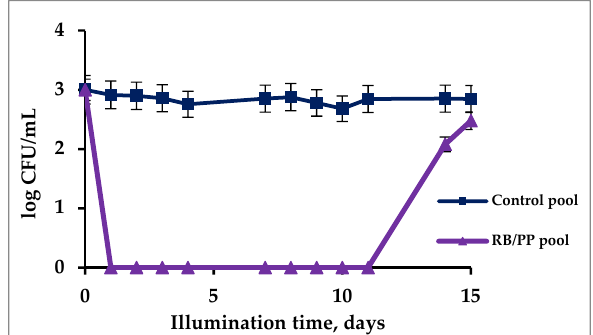
Figure 9. Testing the photostability of RB immobilized in PP under illumination with 1.25 mW/cm 2 white light by its activity against waterborne S. epidermidis added daily to an experimental pool with 4.7 g/L of 1% RB/PP and to a control pool not containing any immobilized RB.